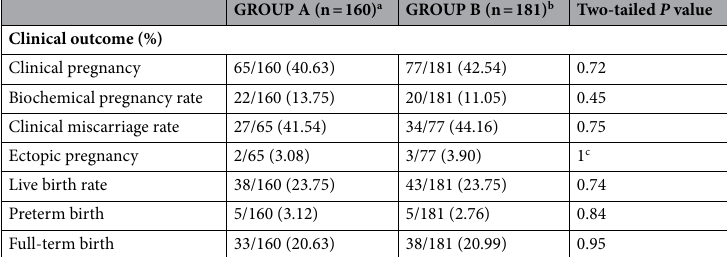
Table 3. Comparison of clinical pregnancy outcomes between the two groups. a In the study group (n = 160), GnRH-a was added based on GnRH-a before hormone administration to adjust the menstruation cycle. b The control group (n = 181) was treated only with an artificial hormone cycle to prepare the endometrium. c This value was calculated by means of Fisher’s exact